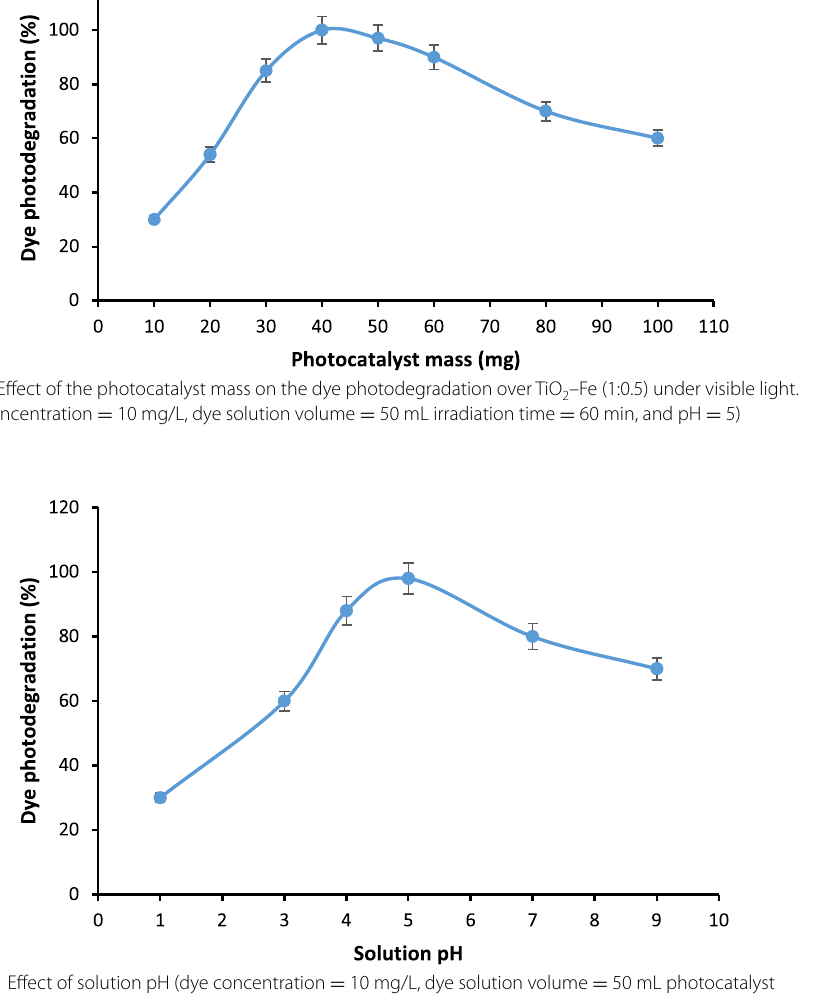
10 mg/L, dye solution volume = 60 =